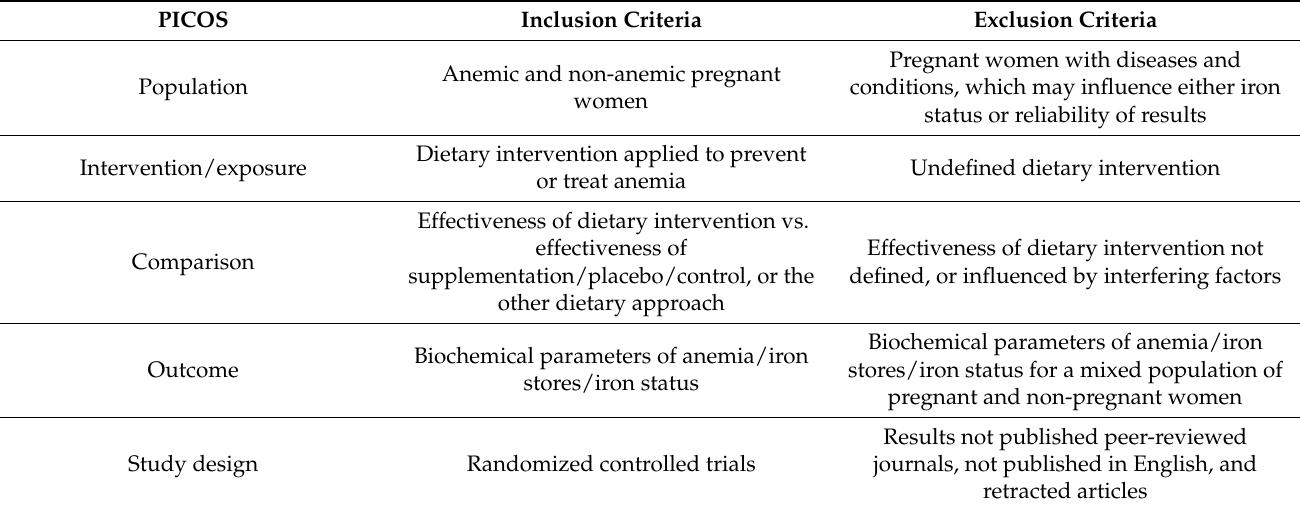
Table 1. The criteria for a population, intervention/exposure, comparator, outcome, and study design